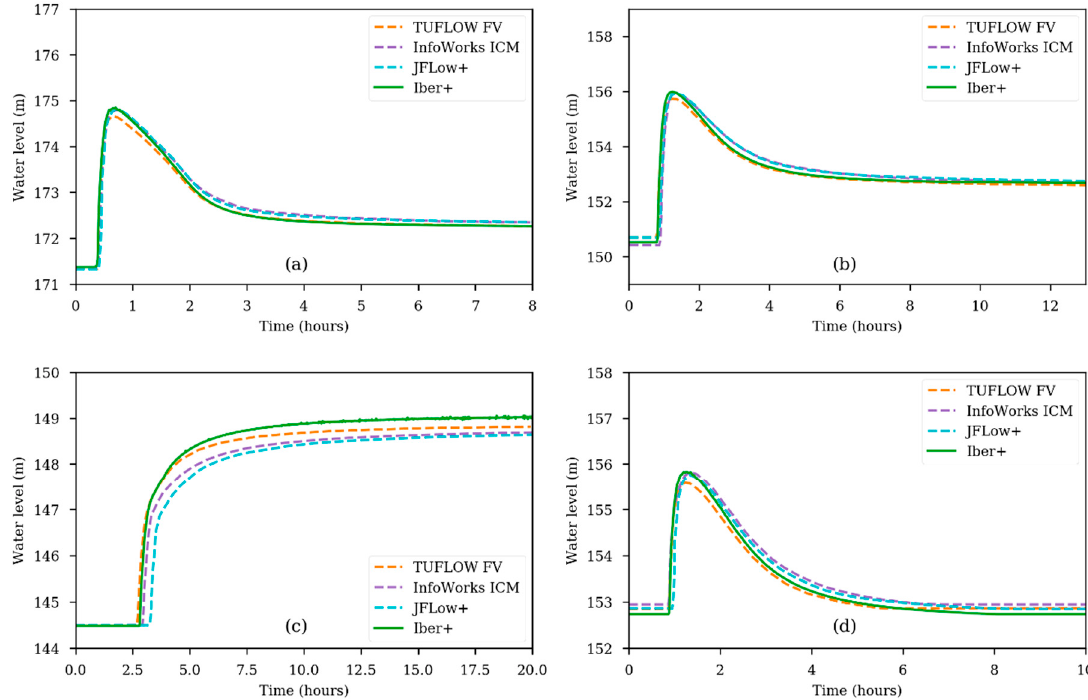
Figure 10. Time series of water level for Test 5 obtained with different numerical models at Point 1 ( a ); Point 3 ( b ); Point 5 ( c ); and Point 7 ( d ).